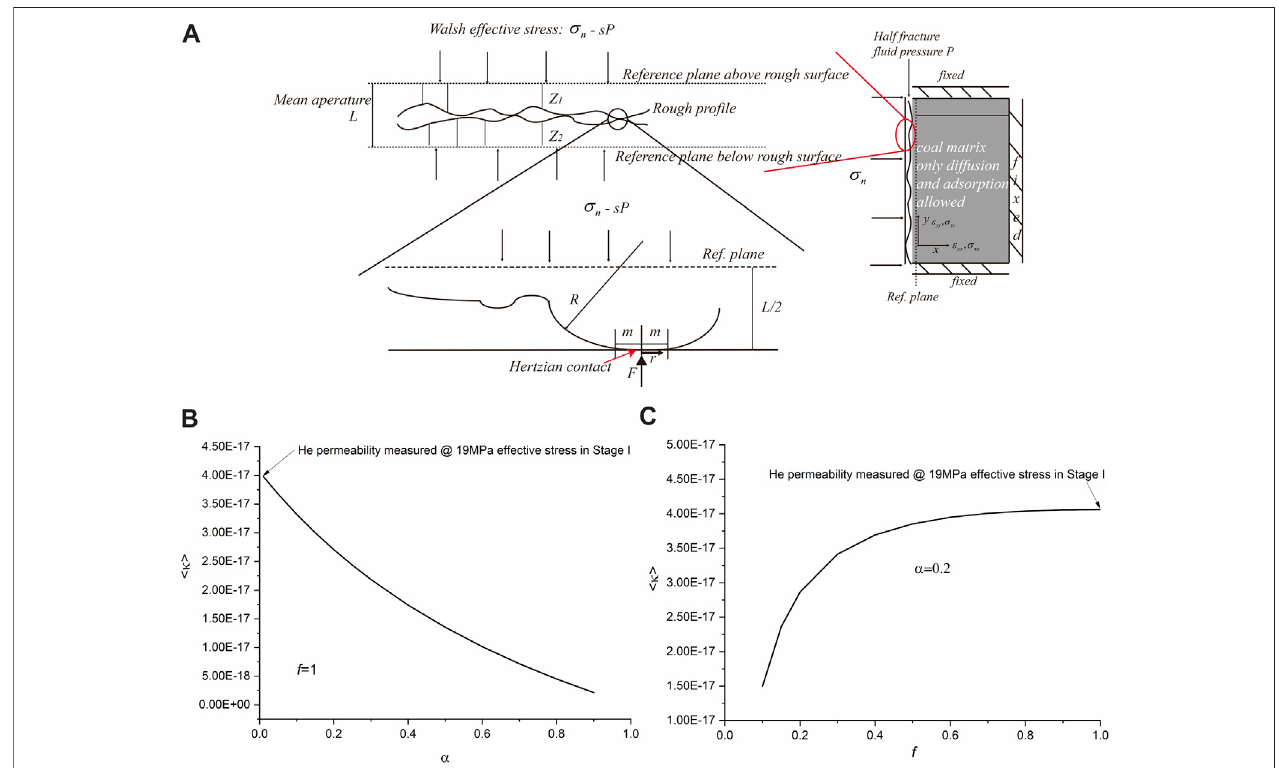
FIGURE8| Aconceptualfracturemodelshownin (A) illustratingtheeffectofasperitycontactsonfracturepermeability,including (B) theeffectofcontactarearatio ( α ) on permeability development when the fracture contains the circular cylindrical asperities only (i.e., f = 1) and (C) the effect of shape factor f for ellipse contacts on permeabilitydevelopmentataconstantcontactarearatioof α =0.2.Notethatthestartingpermeabilityis4×10 − 19 m 2 thatwasmeasuredatStageIforheliumat19 MPa Walsh effective stress ( s =